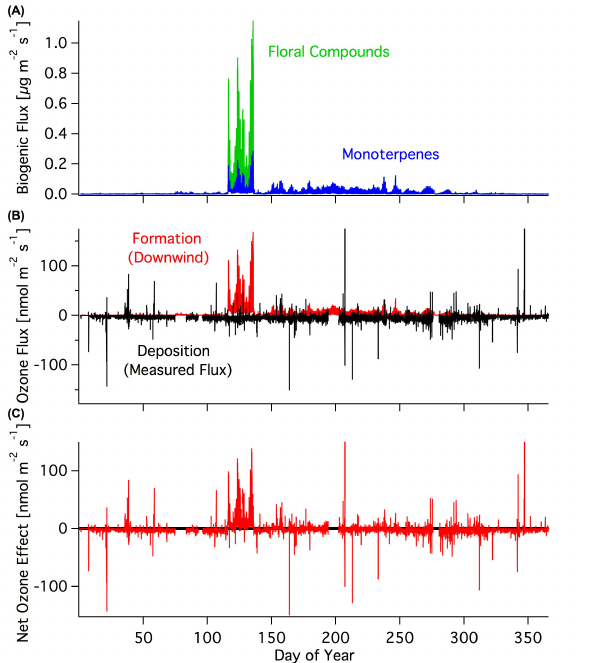
Figure 9. The components of the net ozone flux for the Lindcove or- ange orchard. (A) Modeled fluxes of monoterpenes and floral com- pounds are greatest in the spring during flowering, but are signifi- cant throughout the summer. Sesquiterpene emissions are assumed to be equivalent to monoterpene emissions. (B) Ozone formation and deposition fluxes per acre throughout the year show variable ozone formation with more constant deposition (stomatal and chem- ical). Formation is calculated as potential O 3 (i.e., assuming a VOC- limited regime). (C) The combined effect of these fluxes produces a net flux into the canopy except when biogenic emissions are